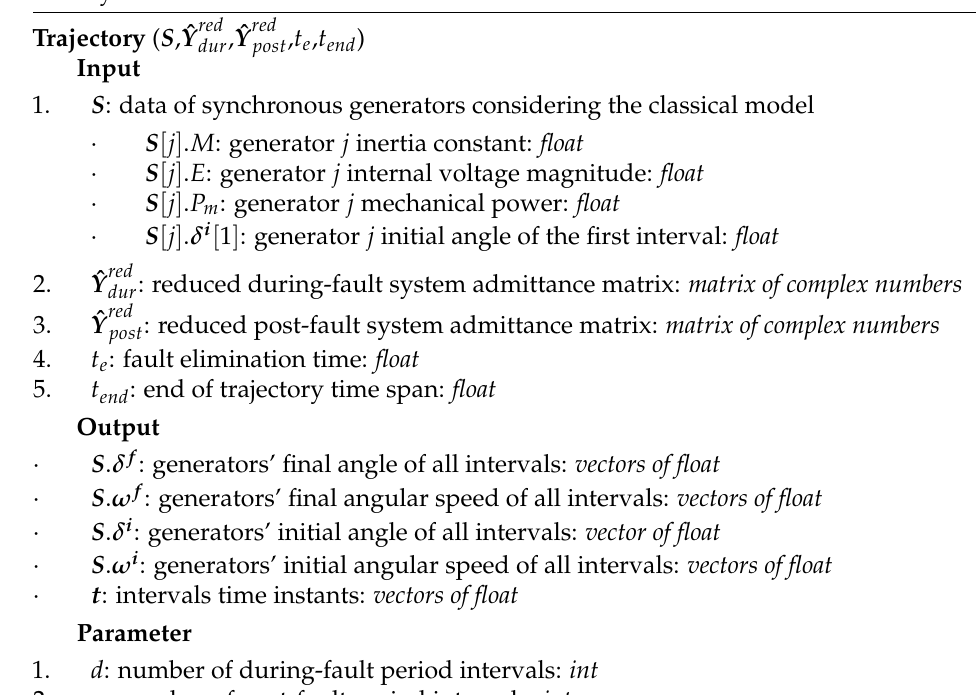
Algorithm A10 Finding synchronous generators’ angle trajectory in time using an individ- ual Taylor